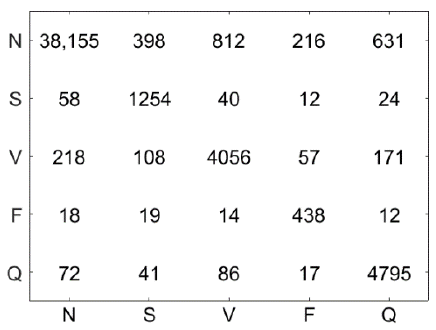
Figure 13. Confusion matrix using the CSDL model.